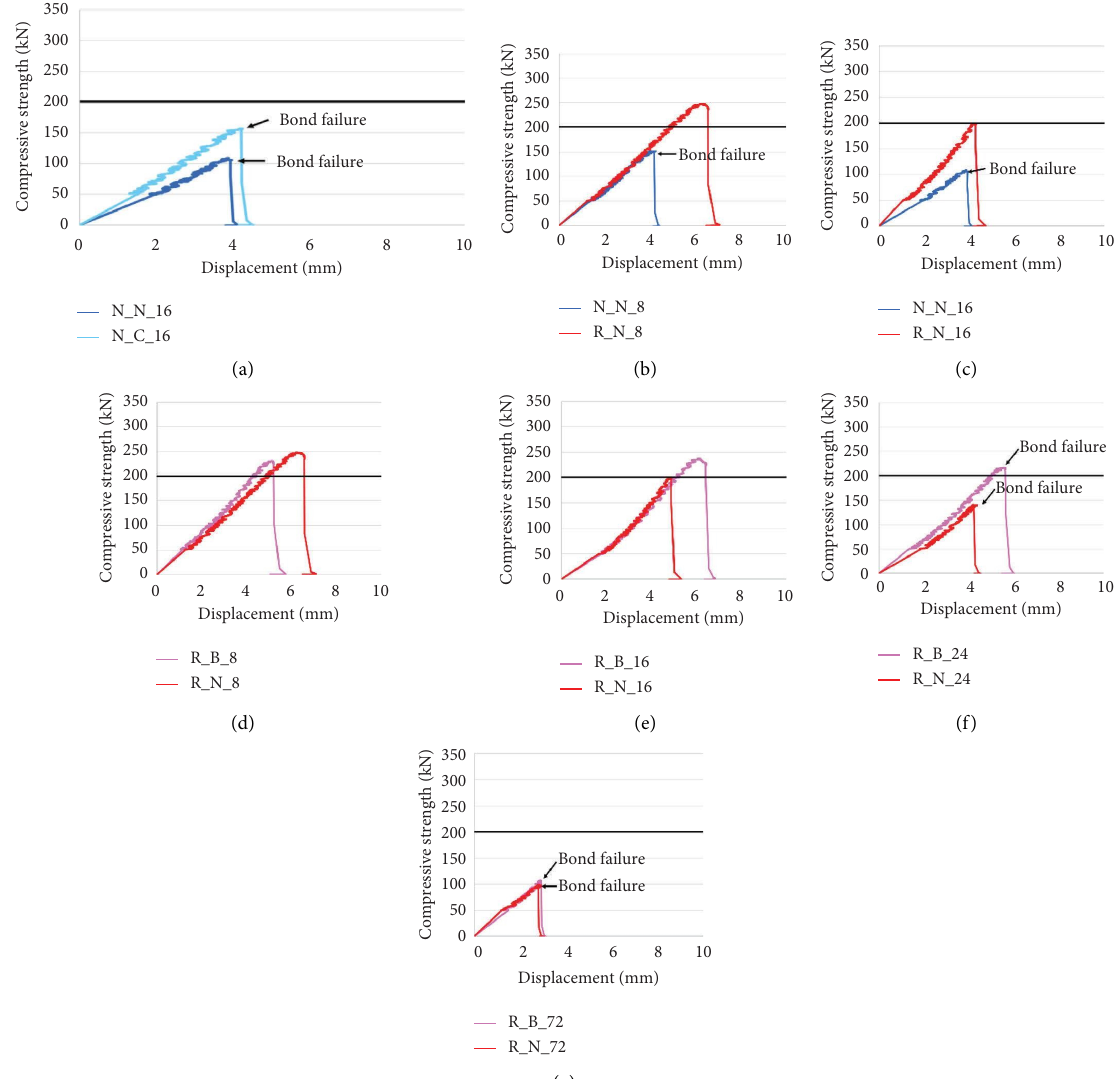
Figure 6: Maximum stroke and load on the 7 th